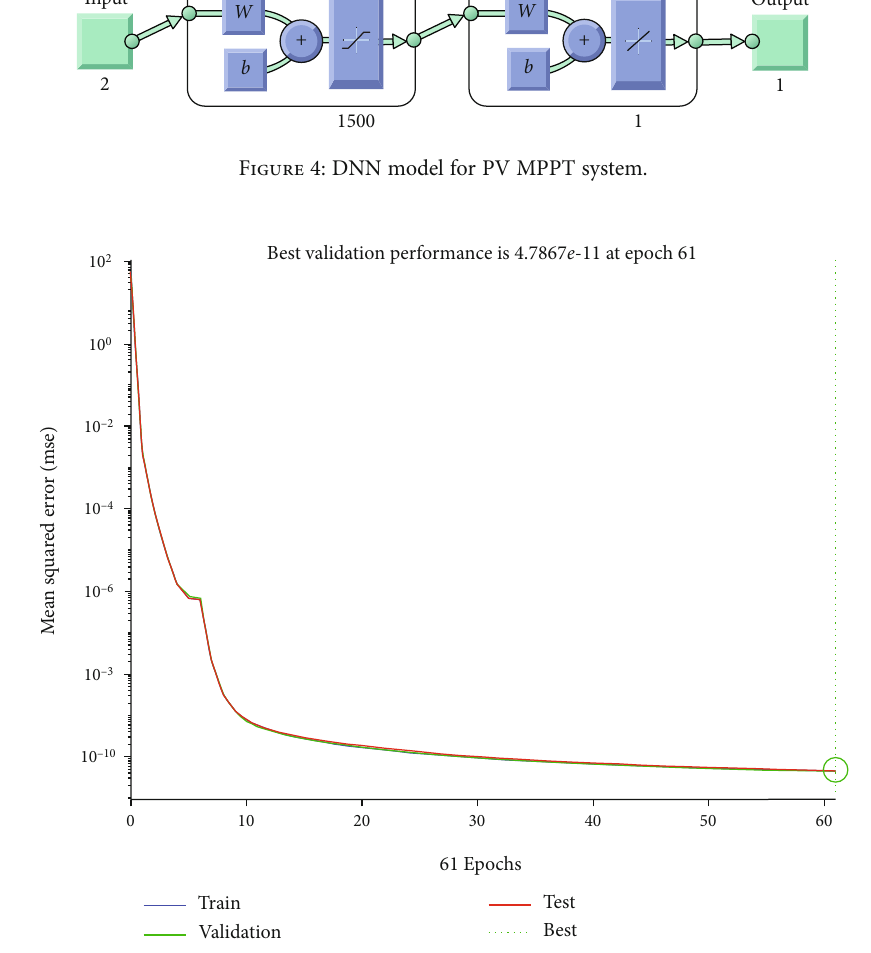
Figure 5: DNN-PV MPPT controller showing best validation